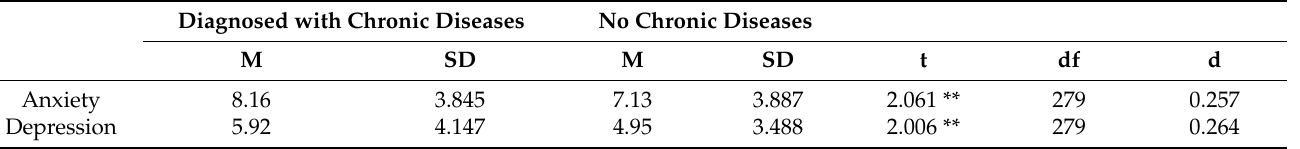
Table 4. Comparisons of HADS scores for participants with and without chronic diseases.